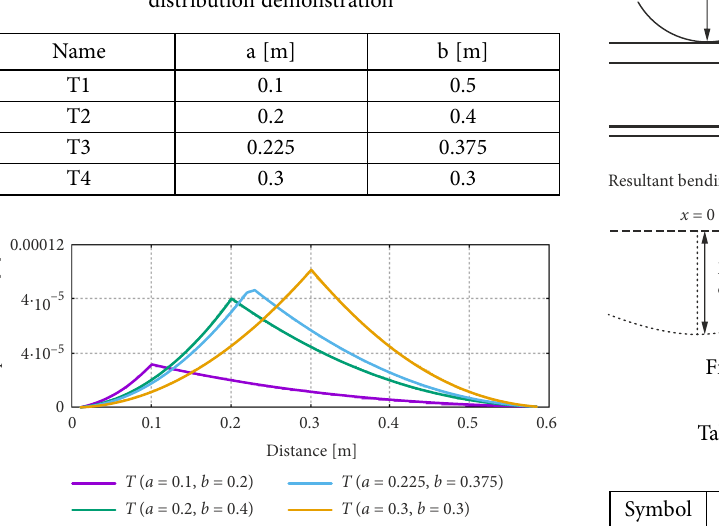
Figure 9. Change in temperature for a concentrated load on a